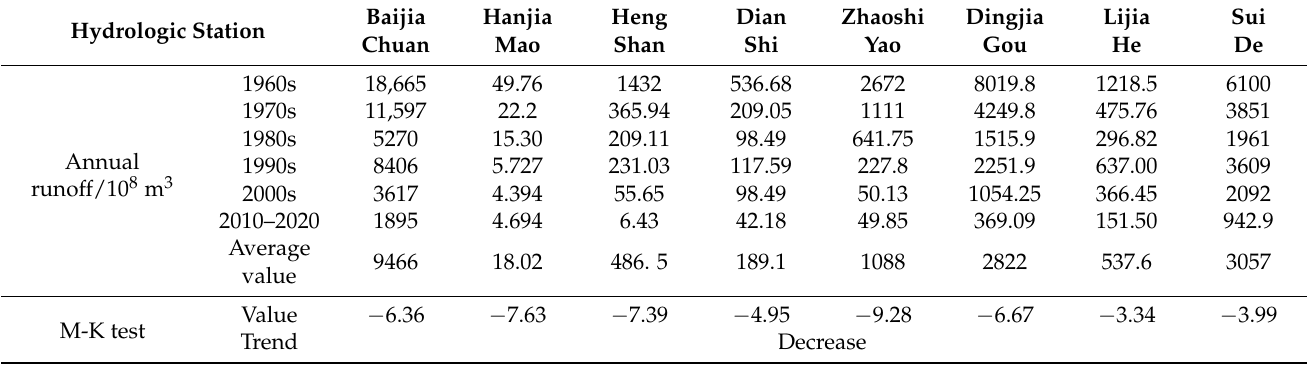
Table 2. Sediment load values and variation trends (M–K test values) at the eight gauging stations in the Wuding River